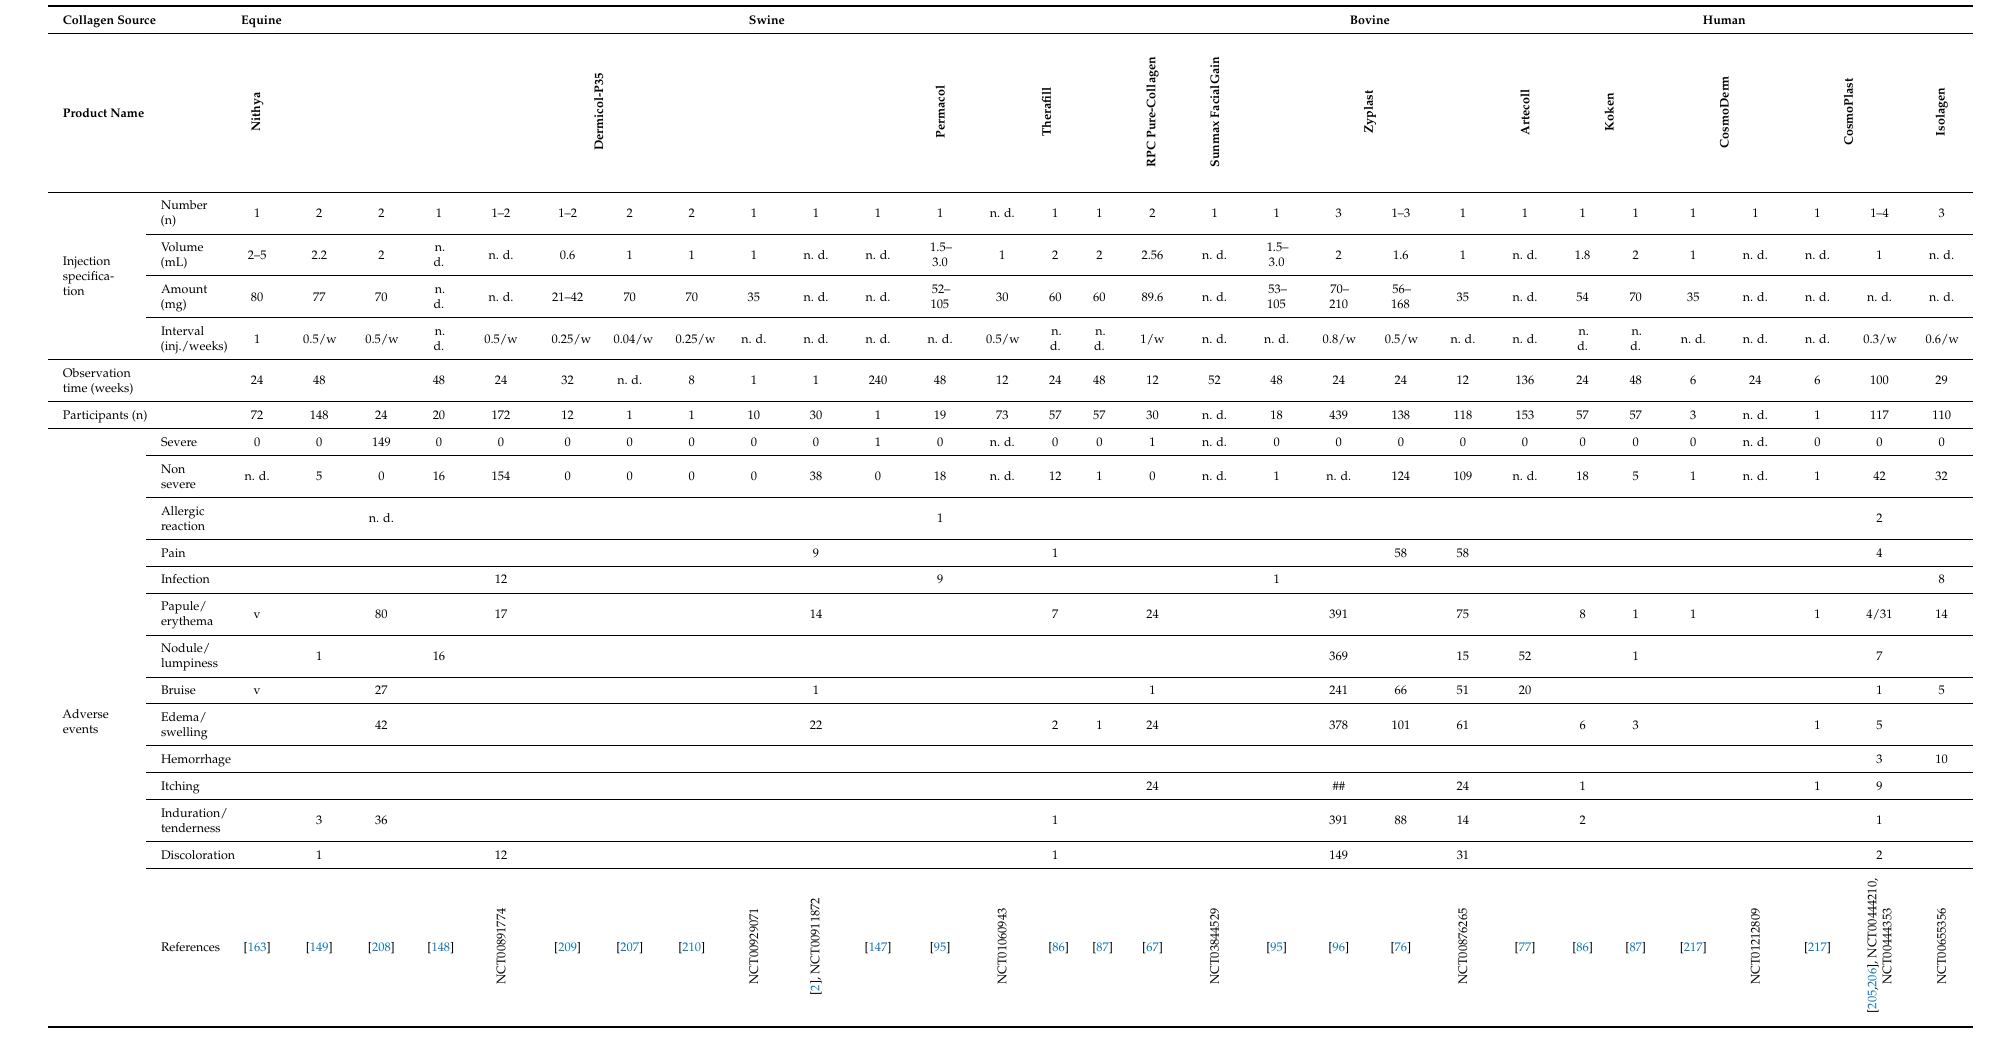
Table 3. Clinical trials details (i.e., participants, injections number, volume and administration time (weeks (w)) and adverse events recurrence on collagen